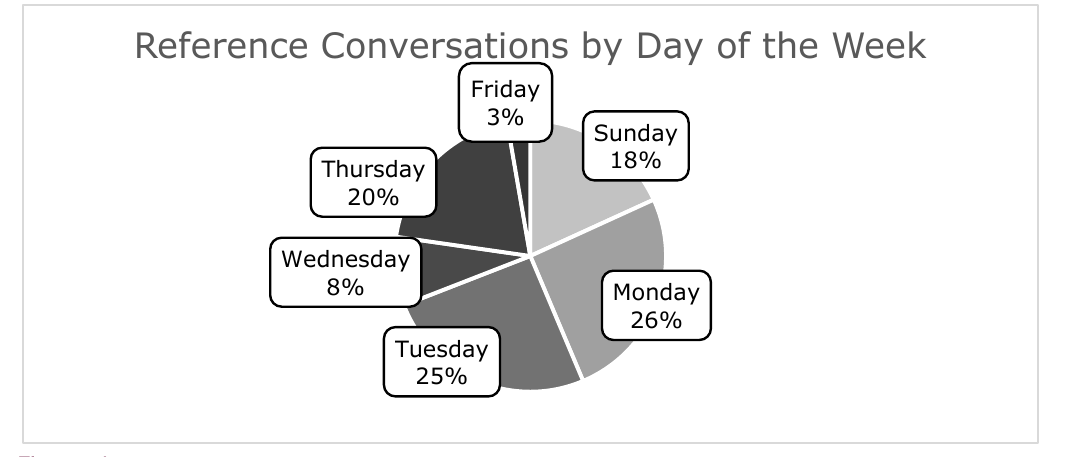
Reference conversations during the fall 2016 semester by day of the